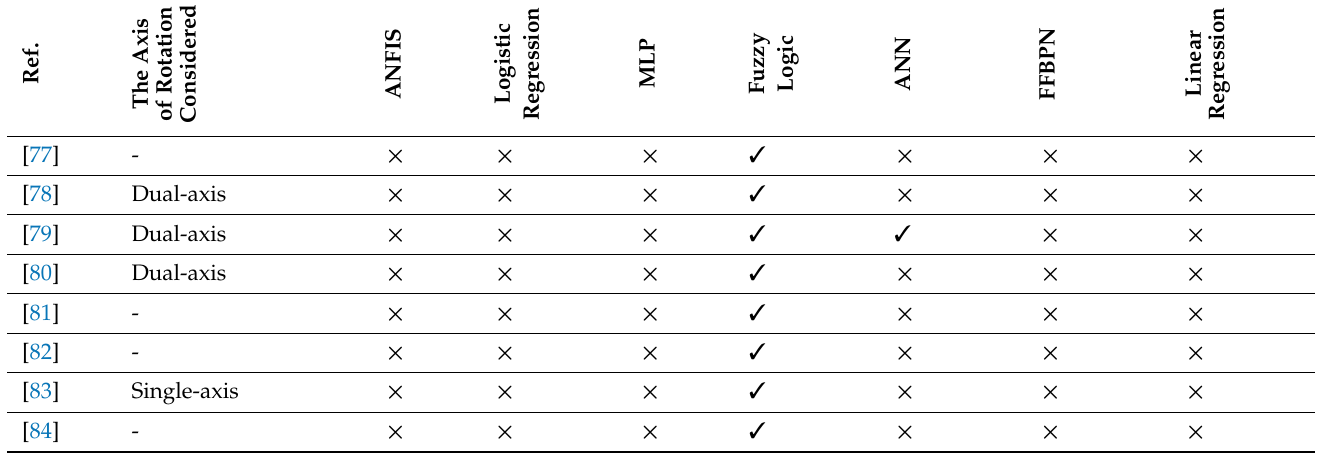
Table 3. Taxonomy of the Learning-Based Model for Solar Tracking